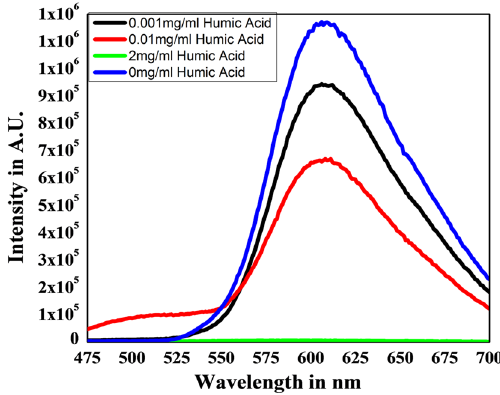
Fig. 3 Fluorescence quenching of 5 × 10 –6 (M) Rubipy in different concentrations of